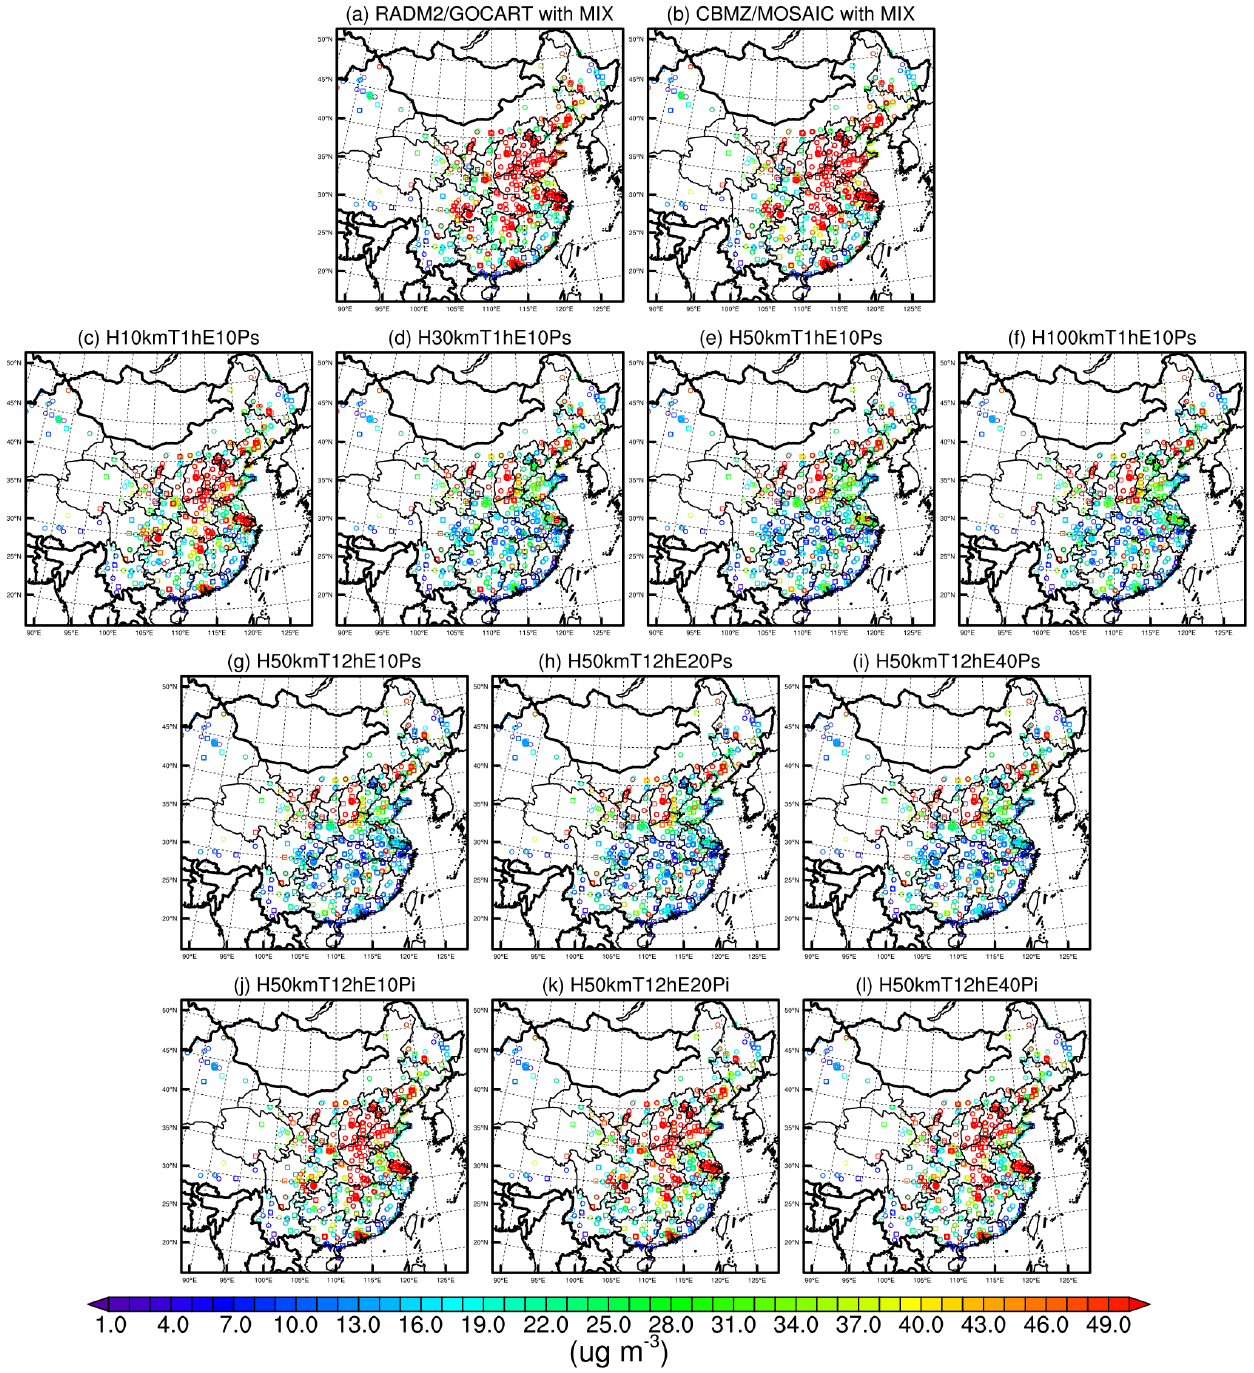
Figure 7. Same as Fig. 6 but for the RMSEs.